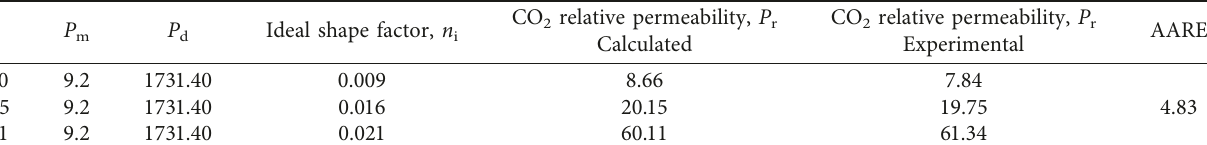
Table 11: Validation of model parameters for CO 2 relative permeability using data from the